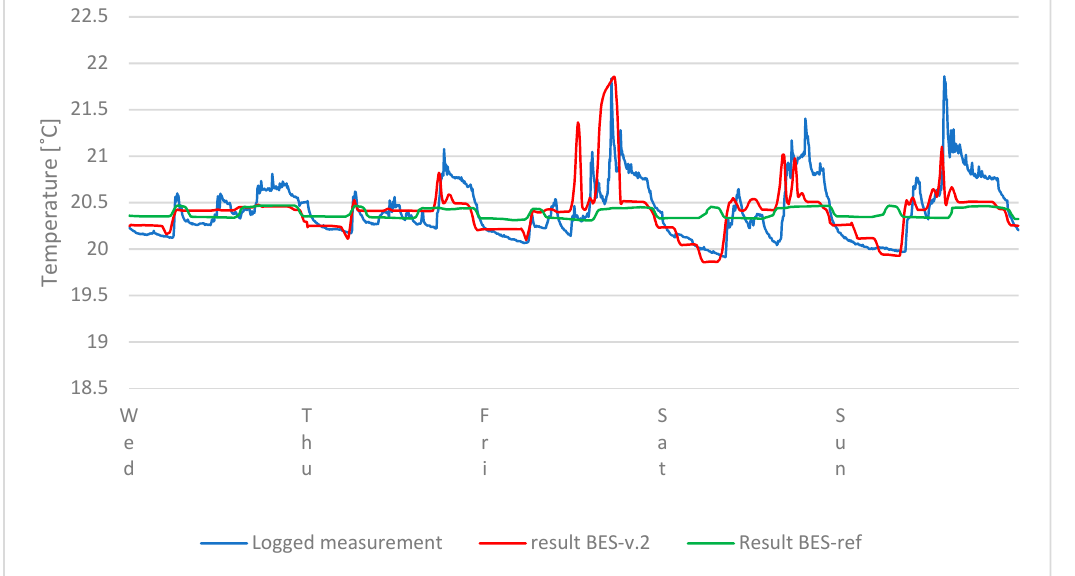
Figure 6. Temperature curves from logged measurements, BES-ref, and BES-v.2 for the period of 21–25 January. The blue curve shows the logged measurements, the red curve shows results from BES-v.2, and the green curve shows results from BES-ref.